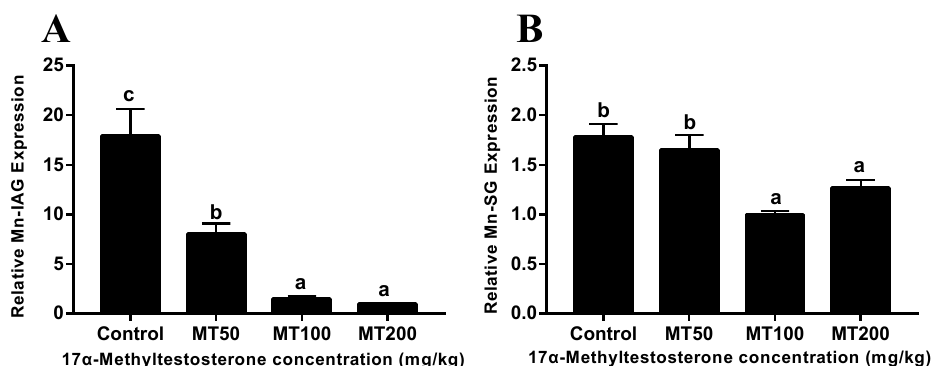
Figure 4. Expression characterization of Mn-IAG and Mn-SG in male prawns treated with different concentrations of MT for 40 days. ( A ) Expression levels of Mn-IAG in male prawns treated with different concentrations of MT for 40 days; ( B ) expression levels of Mn-SG in male prawns treated with different concentrations of MT for 40 days. The amount of Mn-IAG and Mn-SG mRNA was normalized to the EIF transcript level. Data are shown as mean ± SEM of whole prawns from separate individuals in the same group (n = 3). Lowercase letters indicate the difference in expression between different samples.